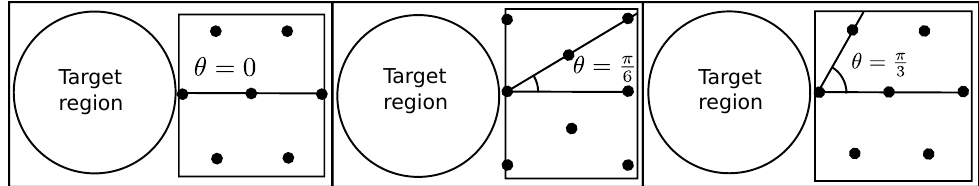
Figure 6. Example of hexagonal packing with different angles. The robots are the black